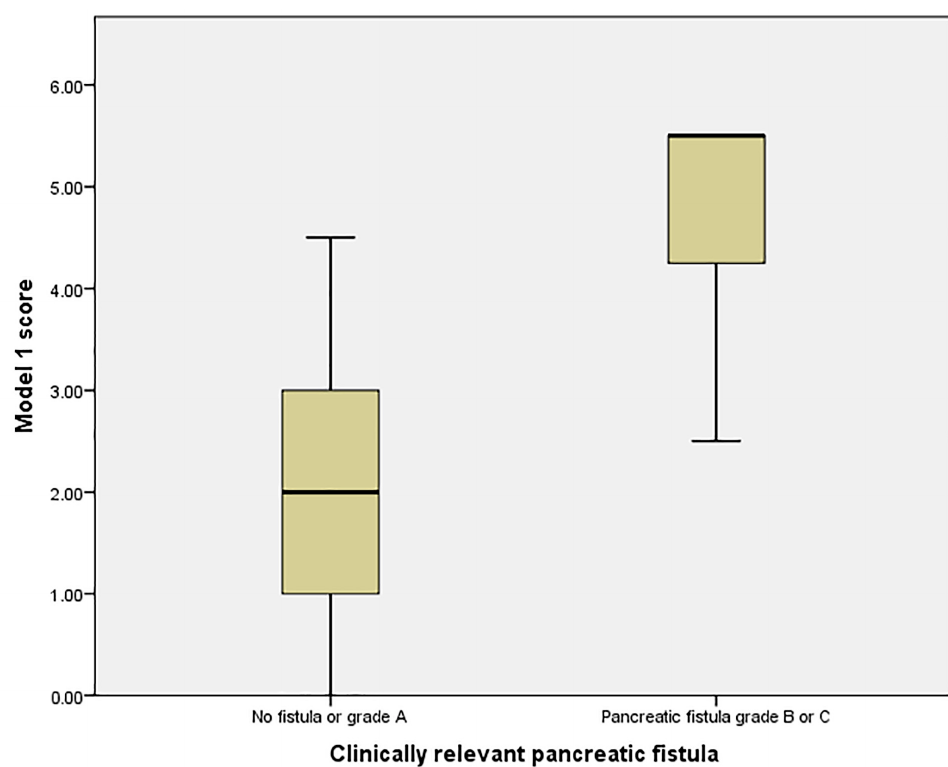
3. Figure 3. Risk groups for the clinically relevant pancreatic fistula (CRPF) in Model 1.